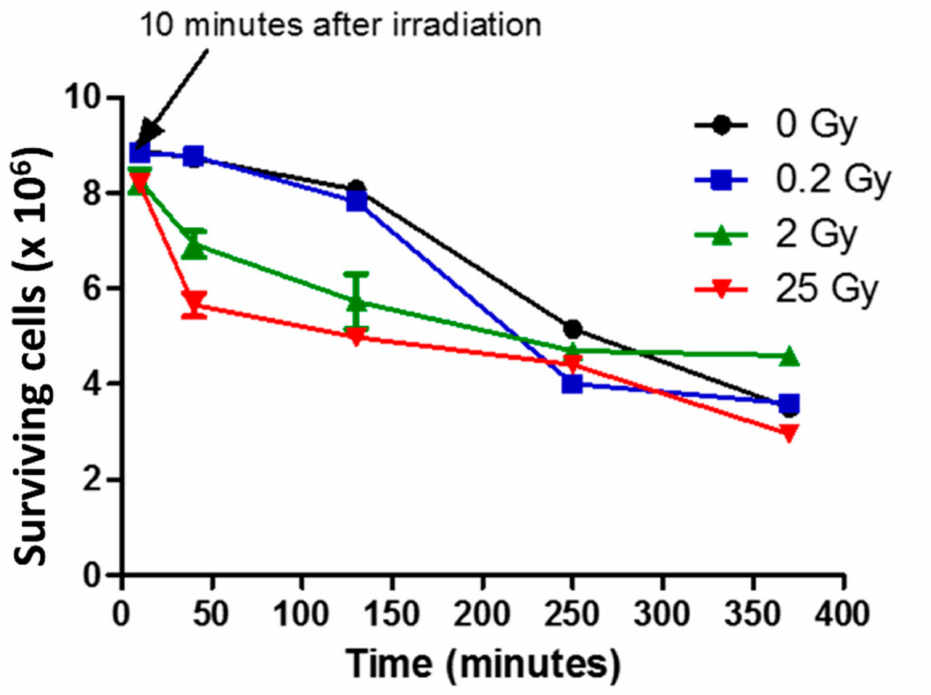
Figure 1. Effect of irradiation on PLB cell survival. Two milliliters each of differentiated PLB-985 cells (9 × 10 6 cells/mL) were irradiated) at 0.2 Gy (0.2 Gy/min; square blue), 2 Gy (0.2 Gy/min; green triangle) and 25 Gy (25 Gy/min; red diamond). Non irradiated samples or sham (black circle) were kept at the same conditions as irradiated ones, except that they were not irradiated. Cells were then centrifuged and divided into 2 equal volumes (1 mL each, one of which was used to study cell death kinetics): 10 min after irradiation, the cells were counted under light microscope using trypan blue exclusion assay ( n = 3). Subsequent counting was done at 40 min ( n = 2), 130 min (2 h) ( n = 2), 250 min (4 h) and 370 min (6 h). Surviving cells are the number of cells that had clear cytoplasm under light microscope. n = 1 for other counting times. The values are the average of the measurements ±